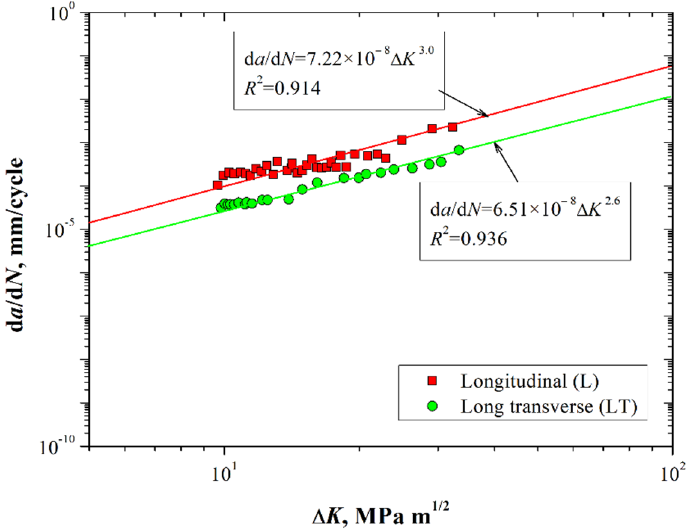
Figure 7. Fatigue crack growth rate as a function of the stress intensity factor range for the 7075-T651 aluminum alloy.